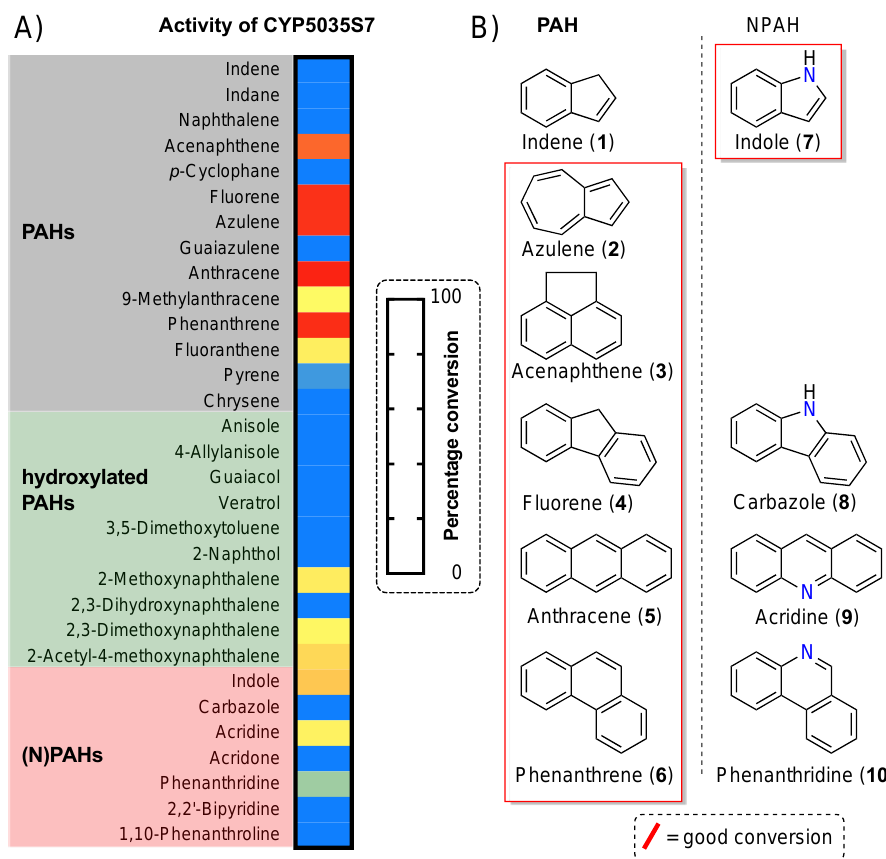
Figure 1. Expansion of the substrate scope of CYP5035S7 towards (N)PAHs. ( A ) The heat map shows the conversion efficiency of CYP5035S7 towards common PAHs, hydroxylated PAHs as well as N - containing PAHs (1 mM of 1 , 0.4 mL, OD 600 = 100, 320 rpm, 17 h, 28 °C). It includes data from our previous publication [28]. ( B ) The contrast between the PAH and NPAH conversions is shown. Introducing more nitrogen atoms as in 1,10-phenanthroline killed the little activity completely, which implies a correlation between activity and the number of heteroatoms within PAHs. Functionalised PAHs were only converted if they were bicyclic naphthalene derivatives with a methoxy functional group as seen by the conversion of 2-methoxynaph- thalene and 2,3-dimethoxynaphthalene as compared to unaccepted 2-naphtol and 2,3-di- hydroxynaphthalene. Such functional features strongly suggested a demethylation ability